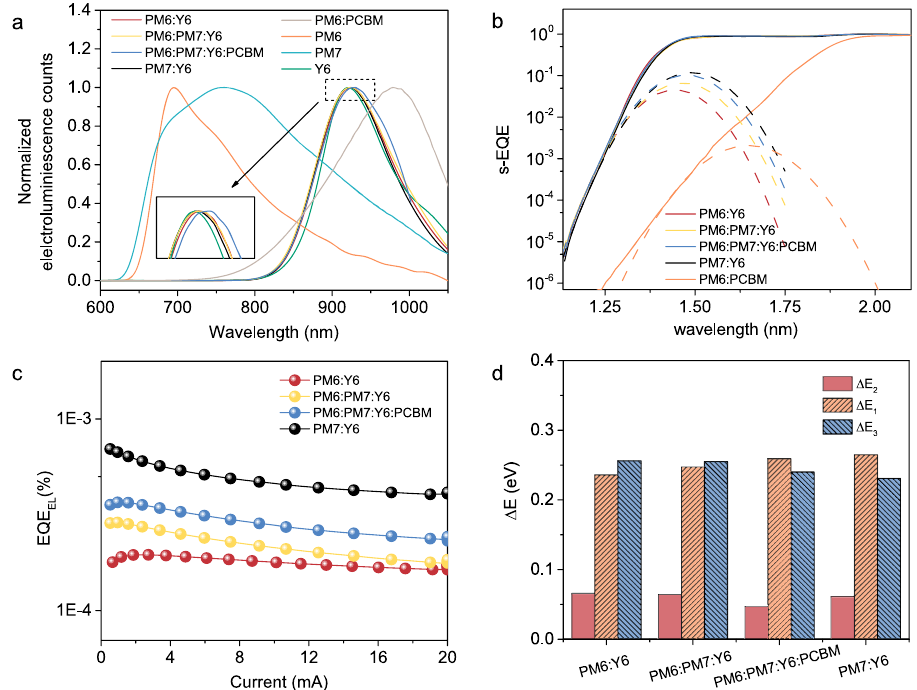
Fig. 3 Energy loss analysis. a Electroluminescence spectra of devices based on the pristine and blended fi lms. b s-EQE and c EQE-EL of the blended devices. d Energy loss histogram, including Δ E 1 , Δ E 2 , and Δ E 3 of blended